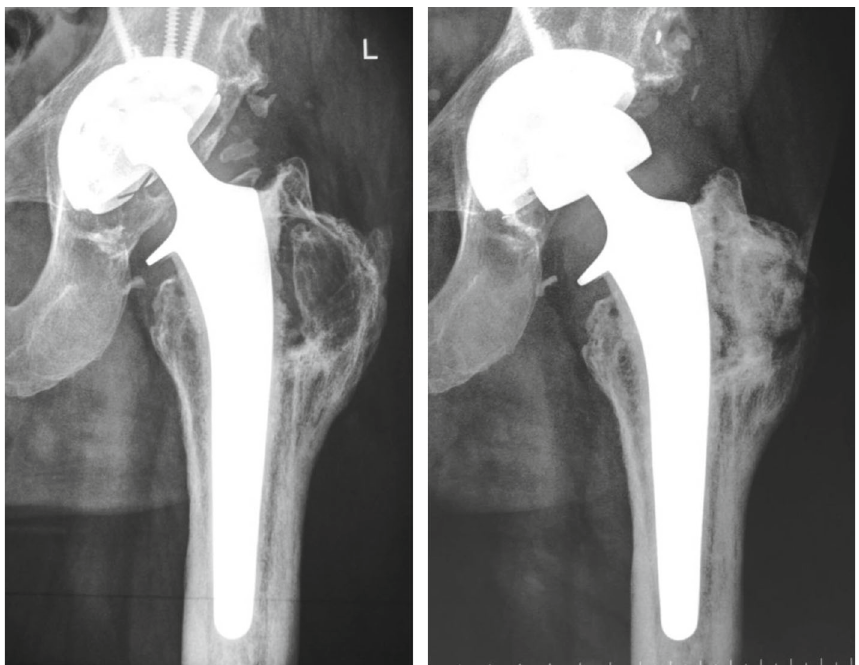
Figure 2: X-ray prior to the second revision showing major osteolysis of the greater trochanter due to PE insert wear (a) (2009); situation after the second revision surgery, in which the greater trochanter was bone grafted, screws were removed, and a 36 mm PE liner was cemented into the uncemented cup (b)